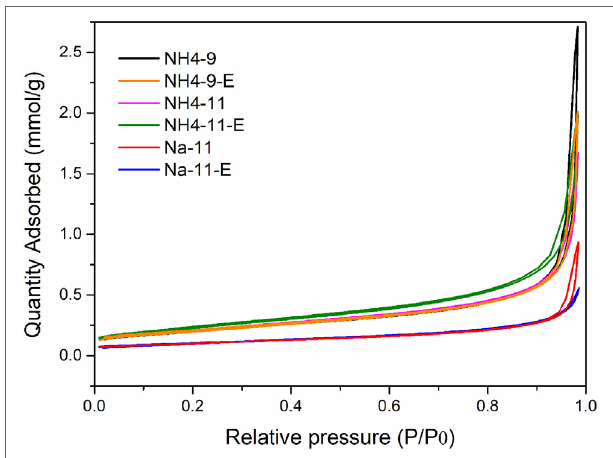
FigUre 2 | N 2 adsorption–desorption isotherms at − 196°C of fresh calcined samples.